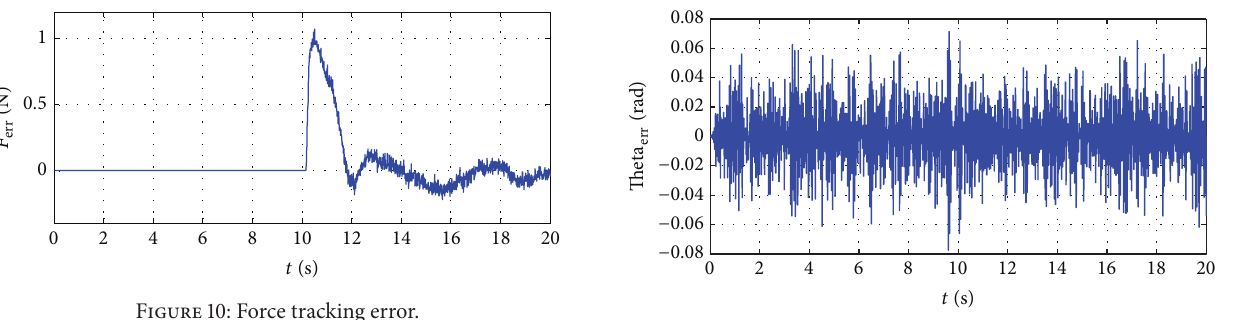
Figure 12: The orientation tracking error theta.